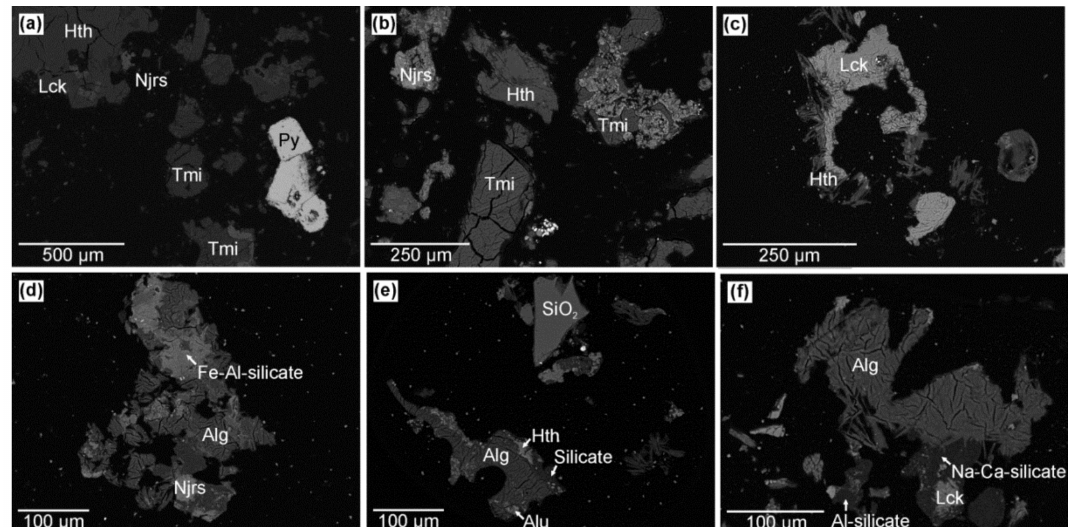
Figure 5. BSE images of efflorescent samples from Dachnoe thermal field: ( a ) alum-group minerals (tschermigite and lonecreekite), natrojarosite, halotrichite; ( b ) tschermigite, natrojarosite, halotrichite; ( c ) lonecreekite, halotrichite; ( d ) natrojarosite and alunogen; ( e ) alunite, alugonen and halotrichite; ( f ) lonecreekite with alunogen. Hth—halotrichite, Njrs—natrojarosite, Lck—lonecreekite, Py—pyrite, Tmi—tschermigite, Alg—alunogen, SiO 2 —silica forms.